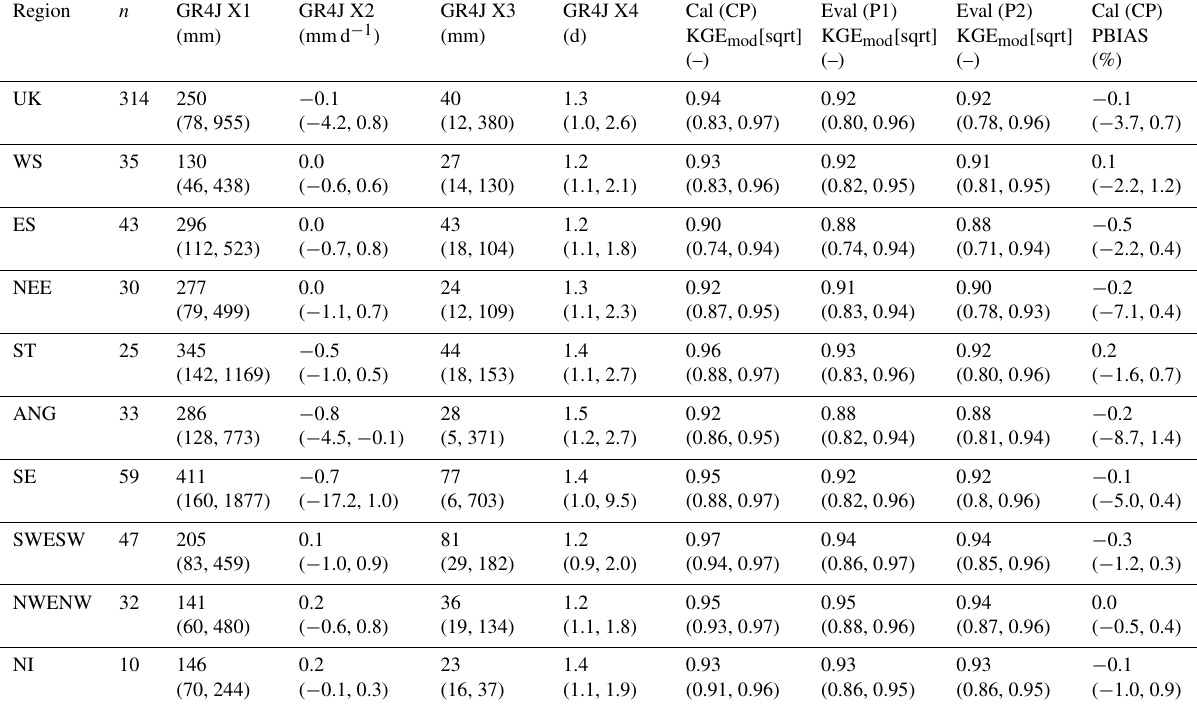
Table 2. Summary statistics of GR4J calibrated parameters and performance metrics for the UK and nine hydroclimate regions shown in Fig. 1. The median across n catchments within each region is given with the 5th and 95th percentile ranges in parentheses. Calibration (Cal) was over the complete period (CP; water years 1983–2014) and evaluation (Eval) for both period 1 (P1; water years 1983–1998) and period 2 (P2;